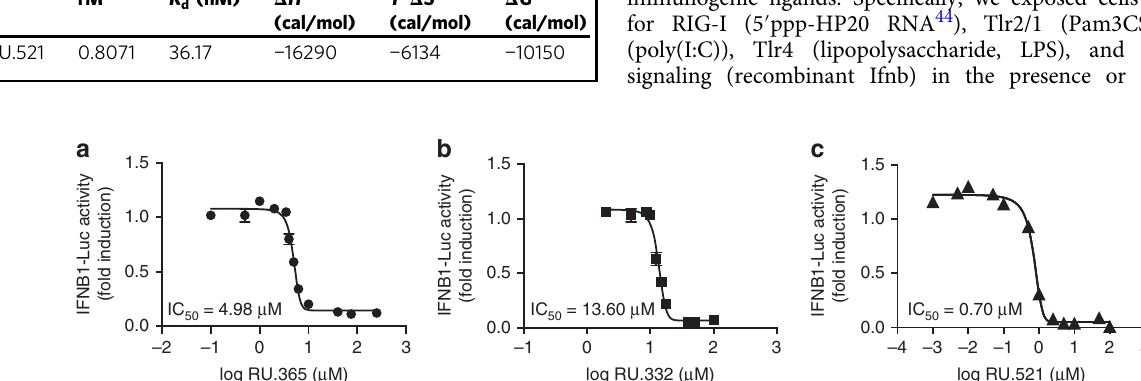
Fig. 5 Small-molecule inhibition of cGAS-dependent interferon induction in cellular assays. RU.365, RU.332, and RU.521 were tested in cellular assays for their effectiveness in inhibiting cGAS activity in dsDNA-stimulated RAW macrophages. The inhibition of type I IFN response via dsDNA was monitored via an interferon sensitive promoter coupled to a luciferase gene. The concentration response curves for RU.365 ( a ), RU.332 ( b ), and RU.521 ( c ) in RAW cells are shown. Error bars represent